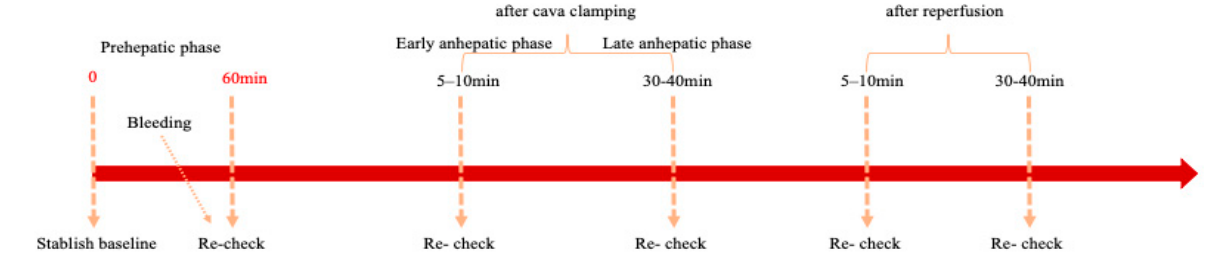
Figure 3. Timing of ROTEM analysis during orthotopic liver transplantation (OLT).